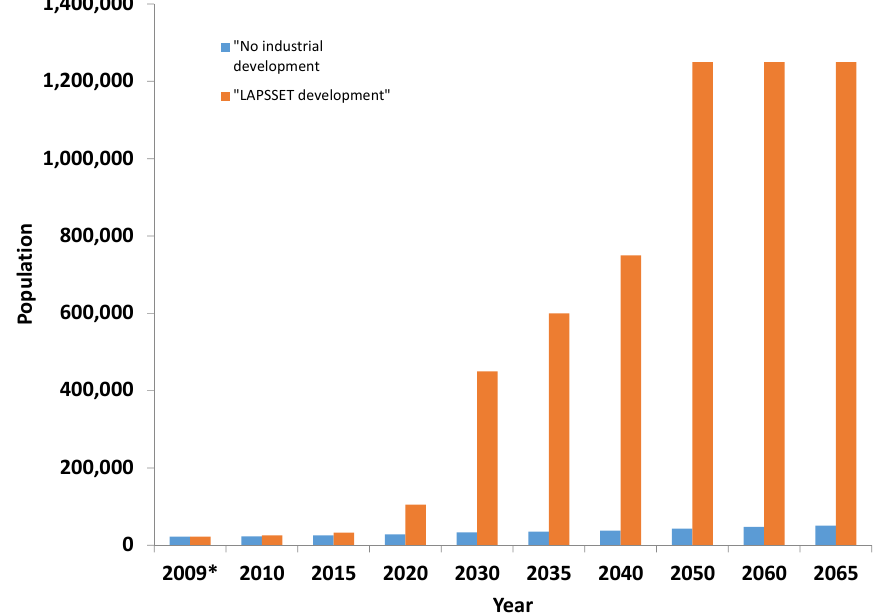
Figure 8. Graph showing the “no industrial development” and “LAPSSET development” projected population growth of Lamu Island against time (years) up to 2050. * 2009 population is official population data from the Population Census Report [50].